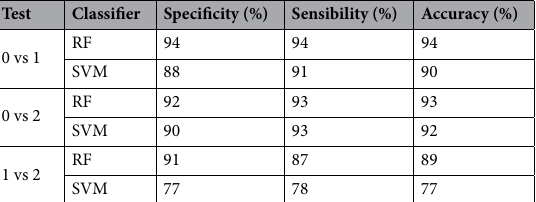
Table 3. Classification results for each two-groups comparison with the two tested classifiers.